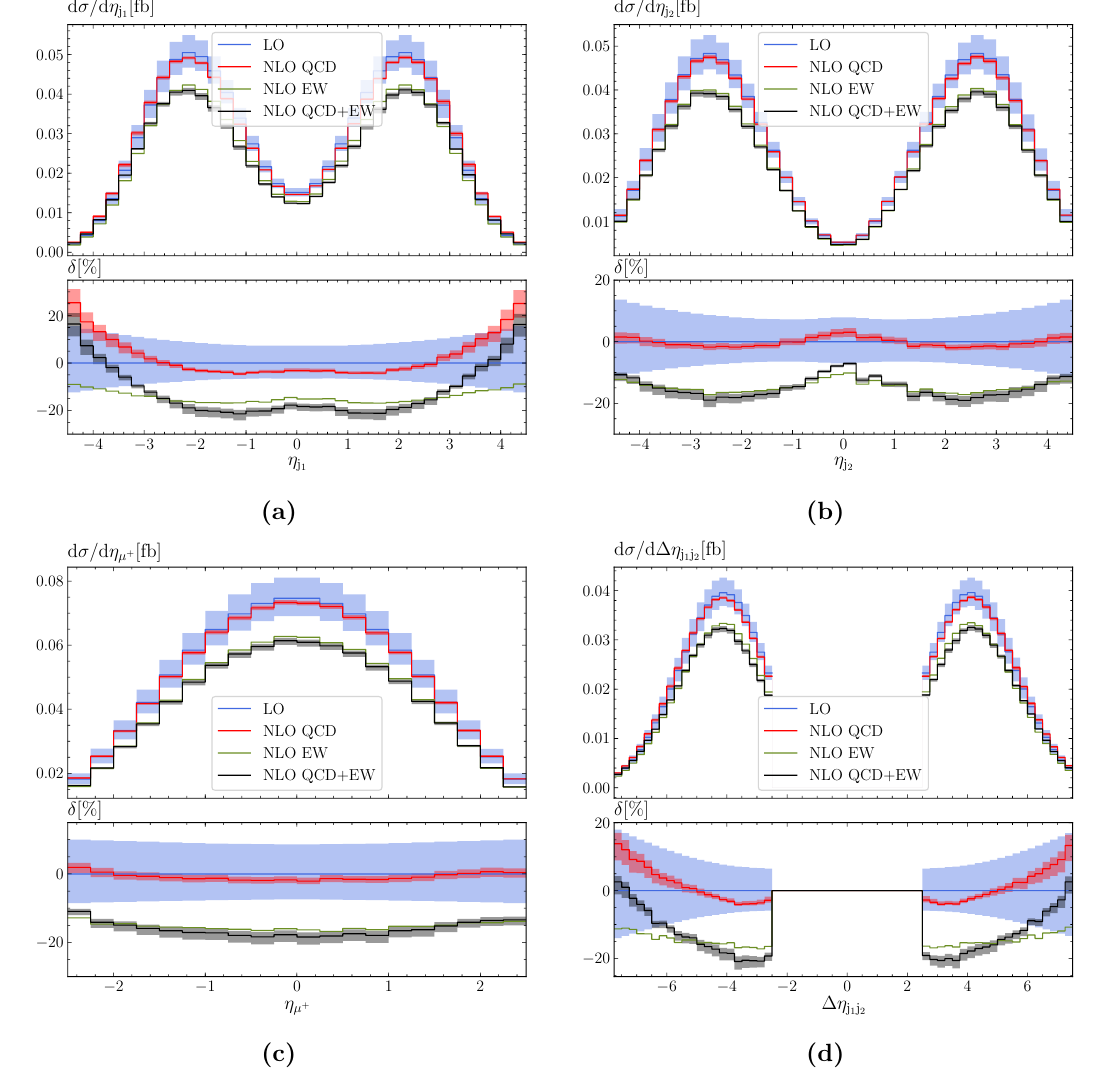
Figure 9. Di(cid:11)erential distributions for pp (cid:22) + (cid:22) (cid:0) e + (cid:23) e jj+ X at the LHC with CM energy 13 TeV: ! (a) pseudo-rapidity of the hardest jet (top left), (b) pseudo-rapidity of the second hardest jet (top right), (c) pseudo-rapidity of the anti-muon (bottom left), and (d) di(cid:11)erence of pseudo-rapidity of the two tagging jets (bottom right). The upper panel shows the LO contributions of order O the two NLO predictions [including (NLO QCD)] as well as their O sum. The lower panel shows the relative NLO corrections with respect to the LO in percent. (cid:1)